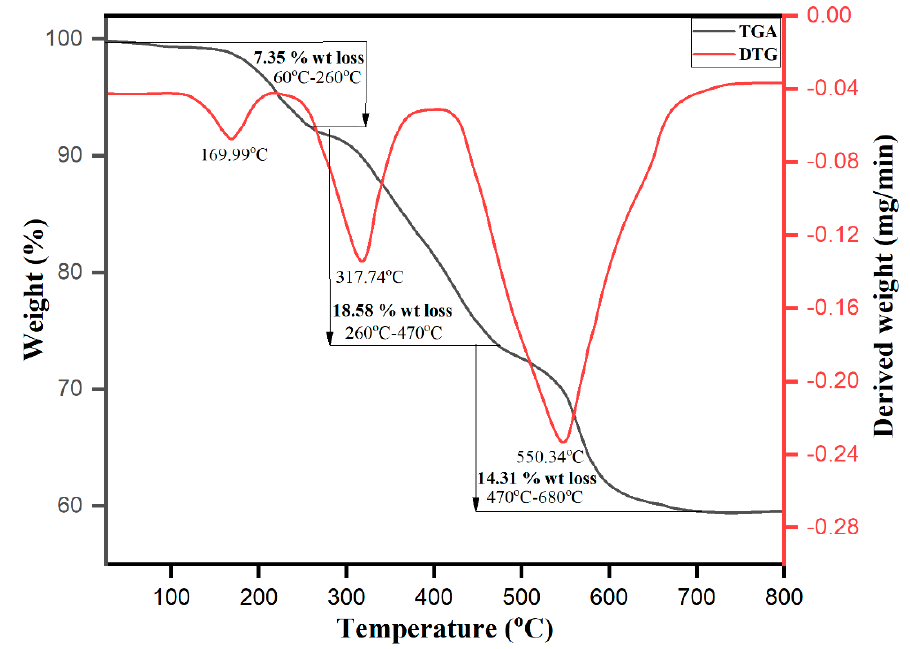
Figure 8. Thermogravimetric analysis and differential thermogravimetry (TGA-DTG) curves of the biosynthesized of Cu-Co-Ni trimetallic nanoparticles.